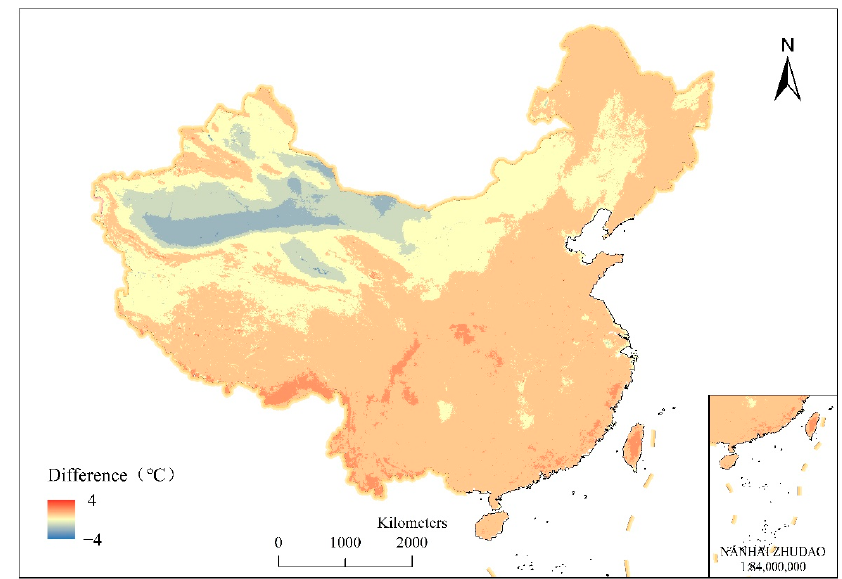
Figure 6. Difference between the HI and air